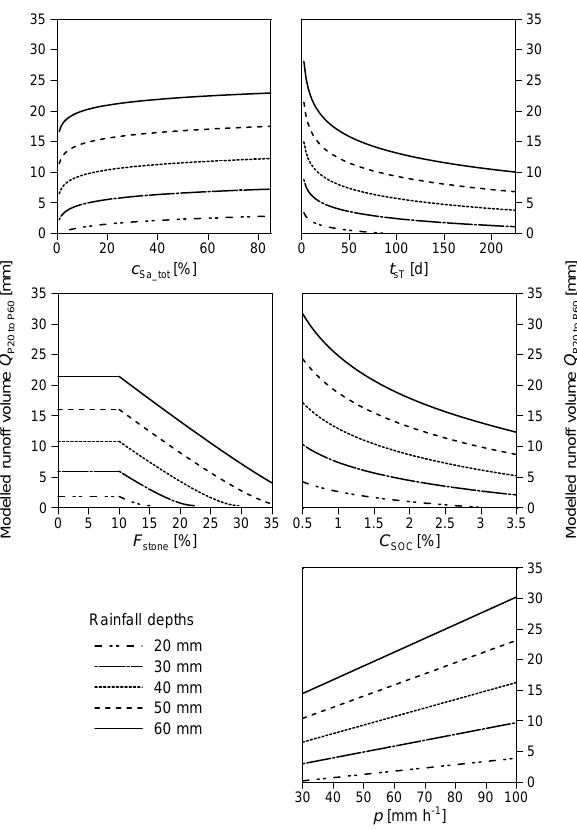
Fig. 3. Modelled accumulated runoff volumes ( Q P 20 to 60 ) for dif- ferent rainfall depths (20 to 60 mm) and varying total sand content C Sa_tot , stone cover F stone , time since tillage t sT , soil organic car- bon content C SOC , and rainfall intensity p as used in Eqs. (1) and (3); for the modelling approach all variables except the one varied were kept constant at their mean value (for values see Fig. 4).